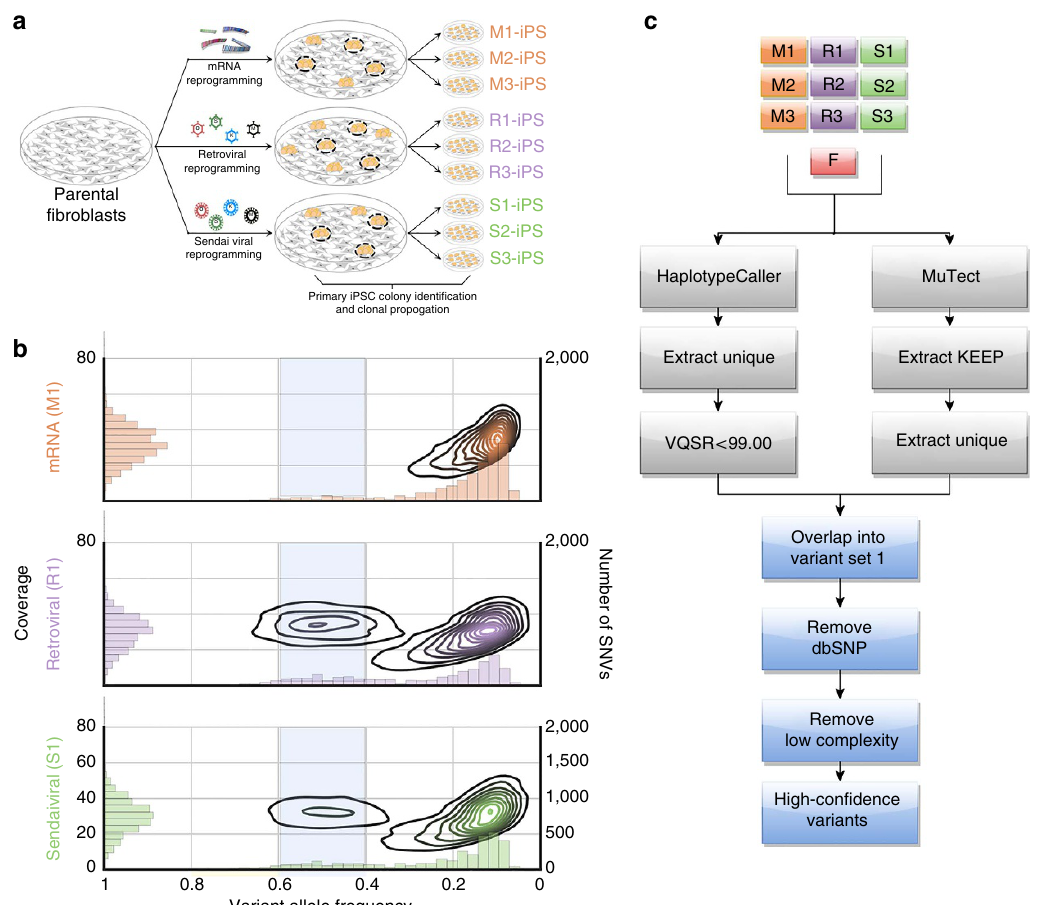
Figure 1 | Experimental and computational design for identifying variants caused by reprogramming. ( a ) Diagram describing the derivation of three biological replicates of each three reprogramming methods: retrovirus, Sendai virus and non-integrating mRNA. ( b ) Kernel density estimation for VAF and coverage for a constituent sample from each reprogramming method: M1 (mRNA), R1 (retrovirus) and S1 (Sendai virus). For R1 and S1, there are denser clusters near 40 (cid:2) coverage and 40–60% VAF than the M1 sample, which indicates they had a higher mutational load during initial doublings. However, it should be noted that all these samples also contained several subclonal variants that are not considered in further analyses. The histograms are intended to aid the readers in interpreting the results of the kernel density estimations. ( c ) Flow diagram detailing the filtering strategy employed to arrive at high-confidence set of SNVs unique to each reprogrammed cell line using MuTect and